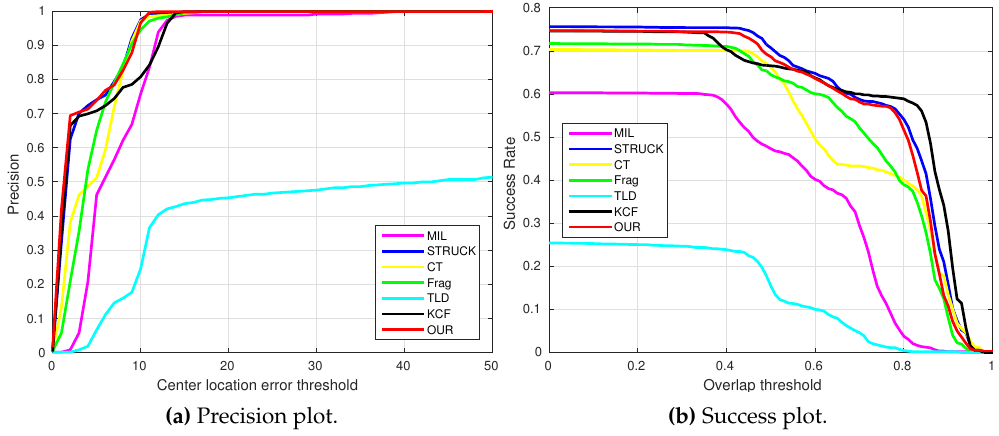
Figure 14. Precision and success plots of all trackers with the moving car image sequence.